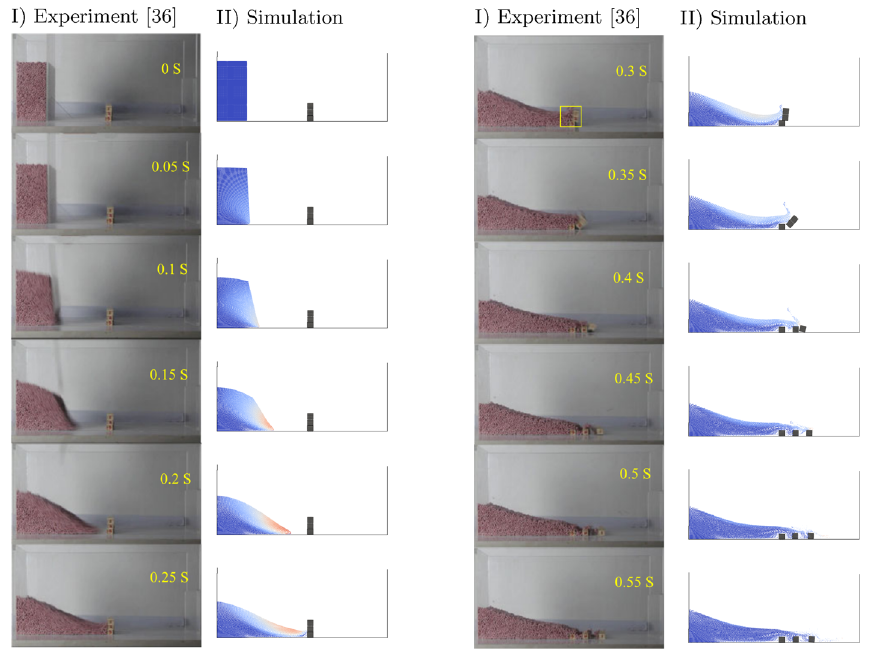
Fig. 10 Granular material calculated with MPM impacting wooden blocks modelled with DEM cluster. Comparison of the experimental results [36] and the obtained numerical solution